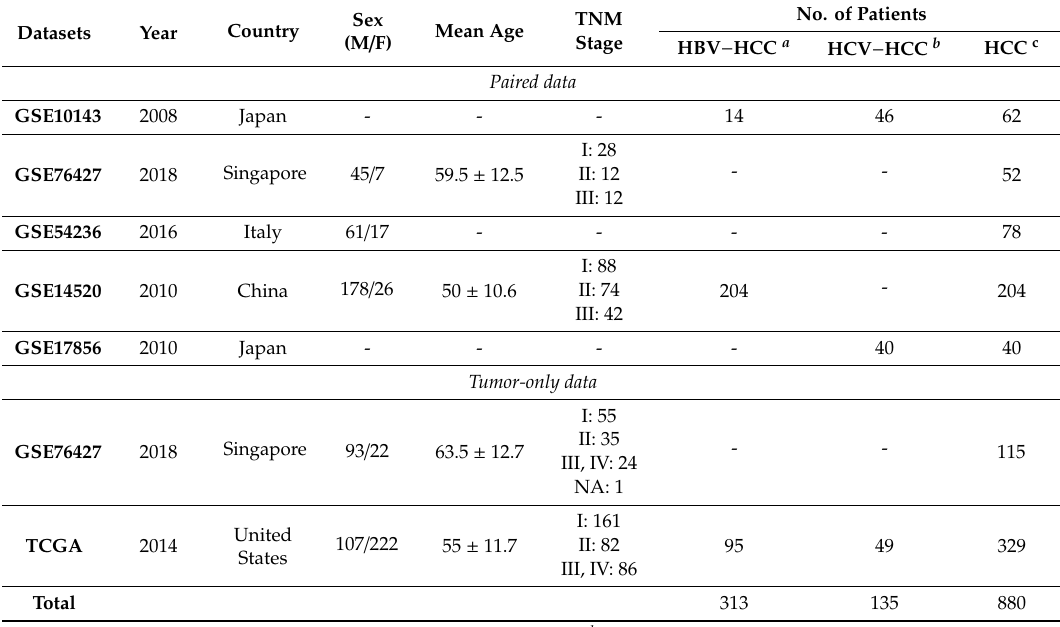
Table 1. Characteristics of 6 public datasets and the classifications of HCC